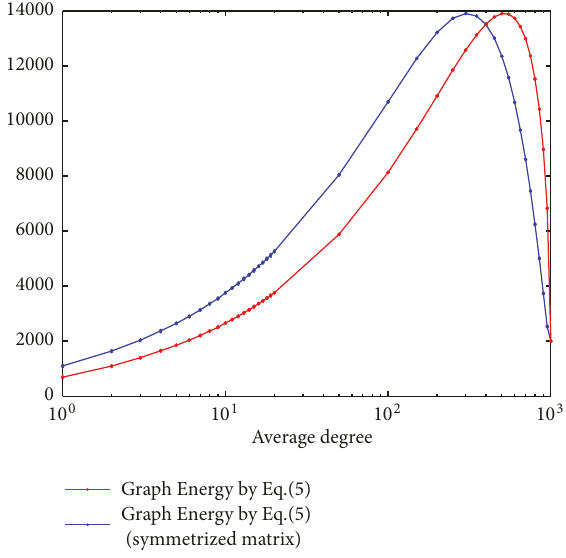
Figure 5: Graph energy calculated by (15) as a function of the average degree of the graph. In the case when the matrix was sym- metrized, the average degree relates to the initial nonsymmetrized matrix. Each graph has 1000